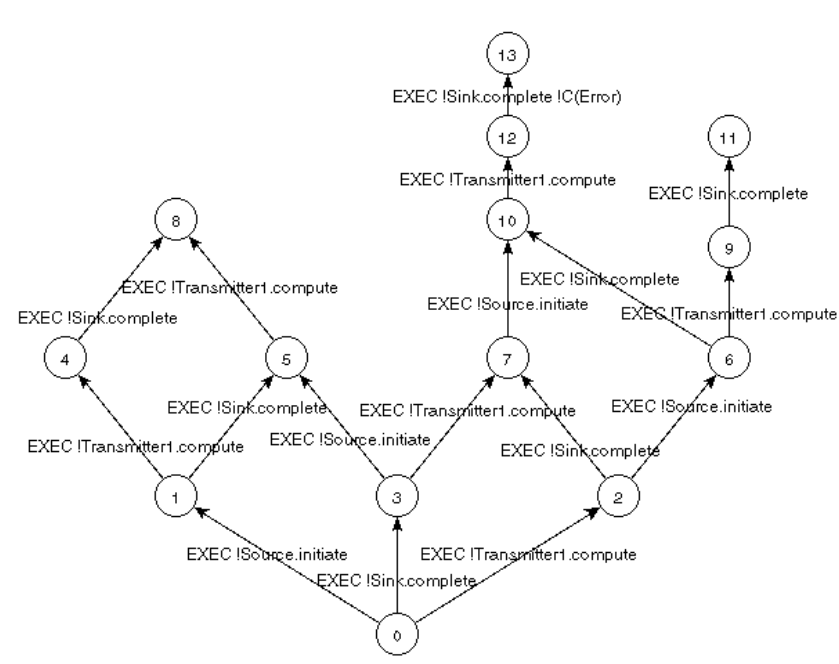
Figure 7 The LTS of the chain benchmark for n = 1 (output of bcg_edit